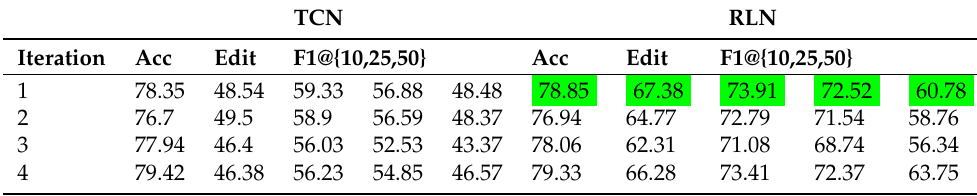
Table 6. RL-SSI in the Juice context.